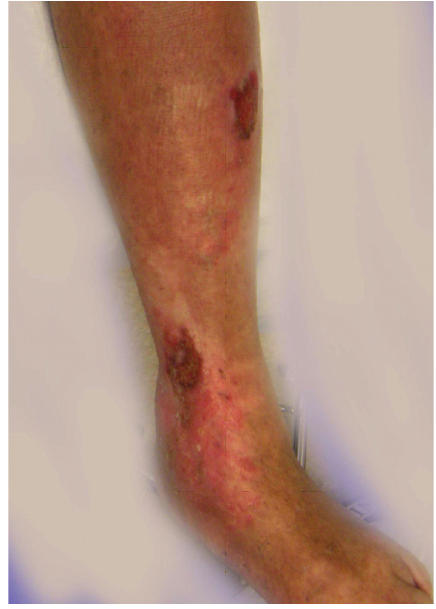
Figure 1: Large nonhealing leg ulcers.